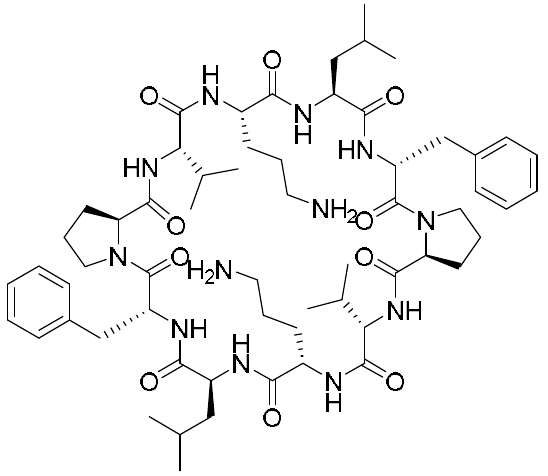
Figure 11. Chemical structure of Gramicidin S (GraS).